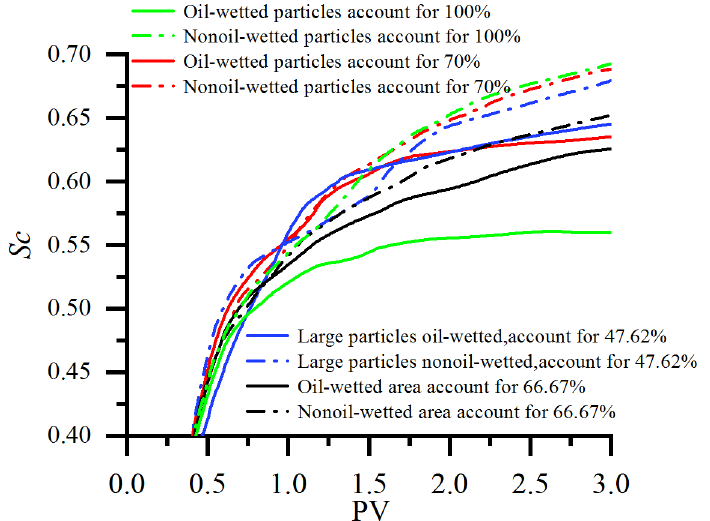
Figure 22. Relationship between PV number and CO 2 saturation ( S C ) under the condition of mixed wettability.